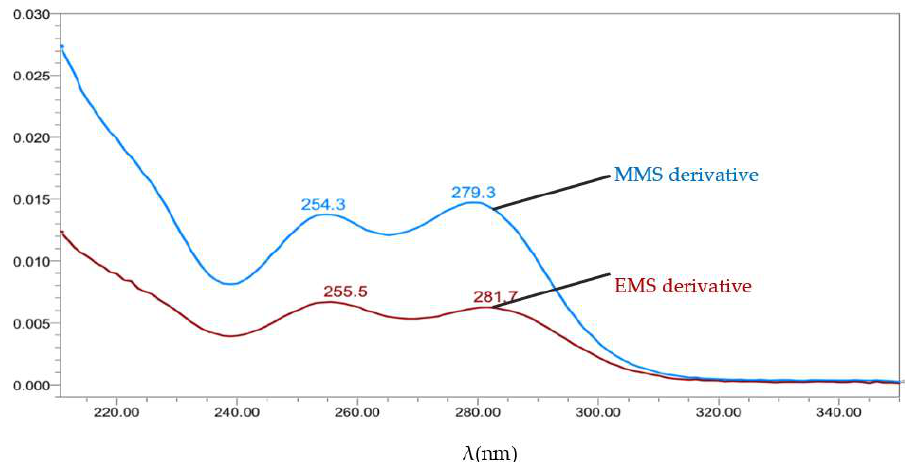
Figure 7. UV spectra of the MMS and EMS derivatives.